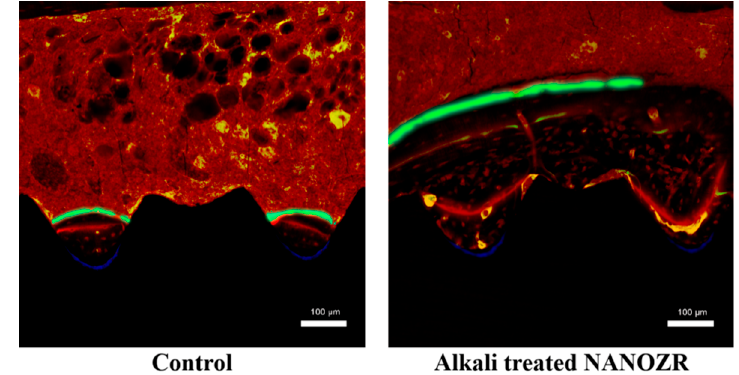
Figure 8. The histological sections were also observed using confocal laser scanning microscopy for dynamic histomorphometry according to fluorescence labeling (blue: 1 week of new bone, yellow: 4 week of new bone, green: 8 week of new bone, red: osteoid). Three colored lines of blue (oxytetracycline hydrochloride, one week), red (Alizarin red S, four weeks), and green (calcein, eight weeks) were found in the implanted surrounding tissues.